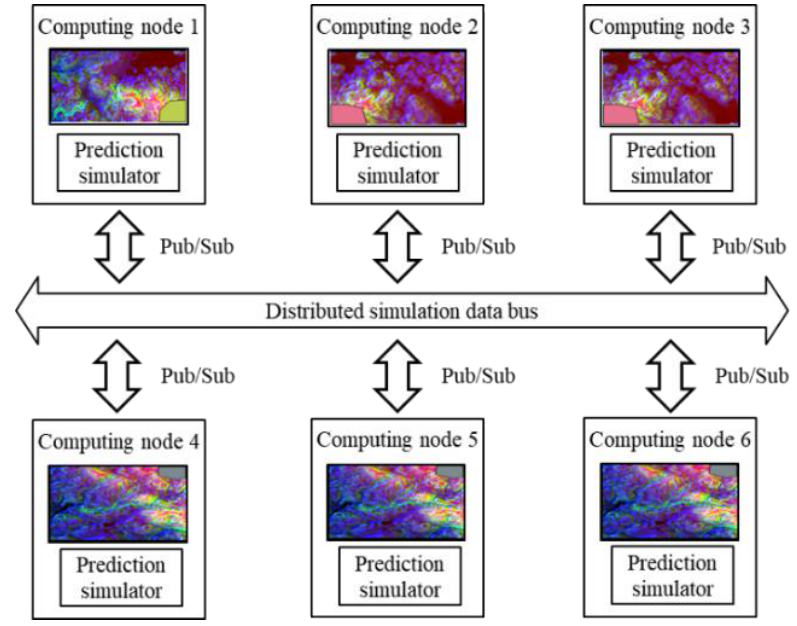
Figure 10. The architecture of the distributed computing scheme.